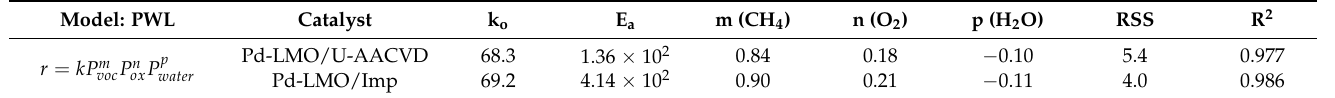
Table 4. Kinetics parameters based on power-law